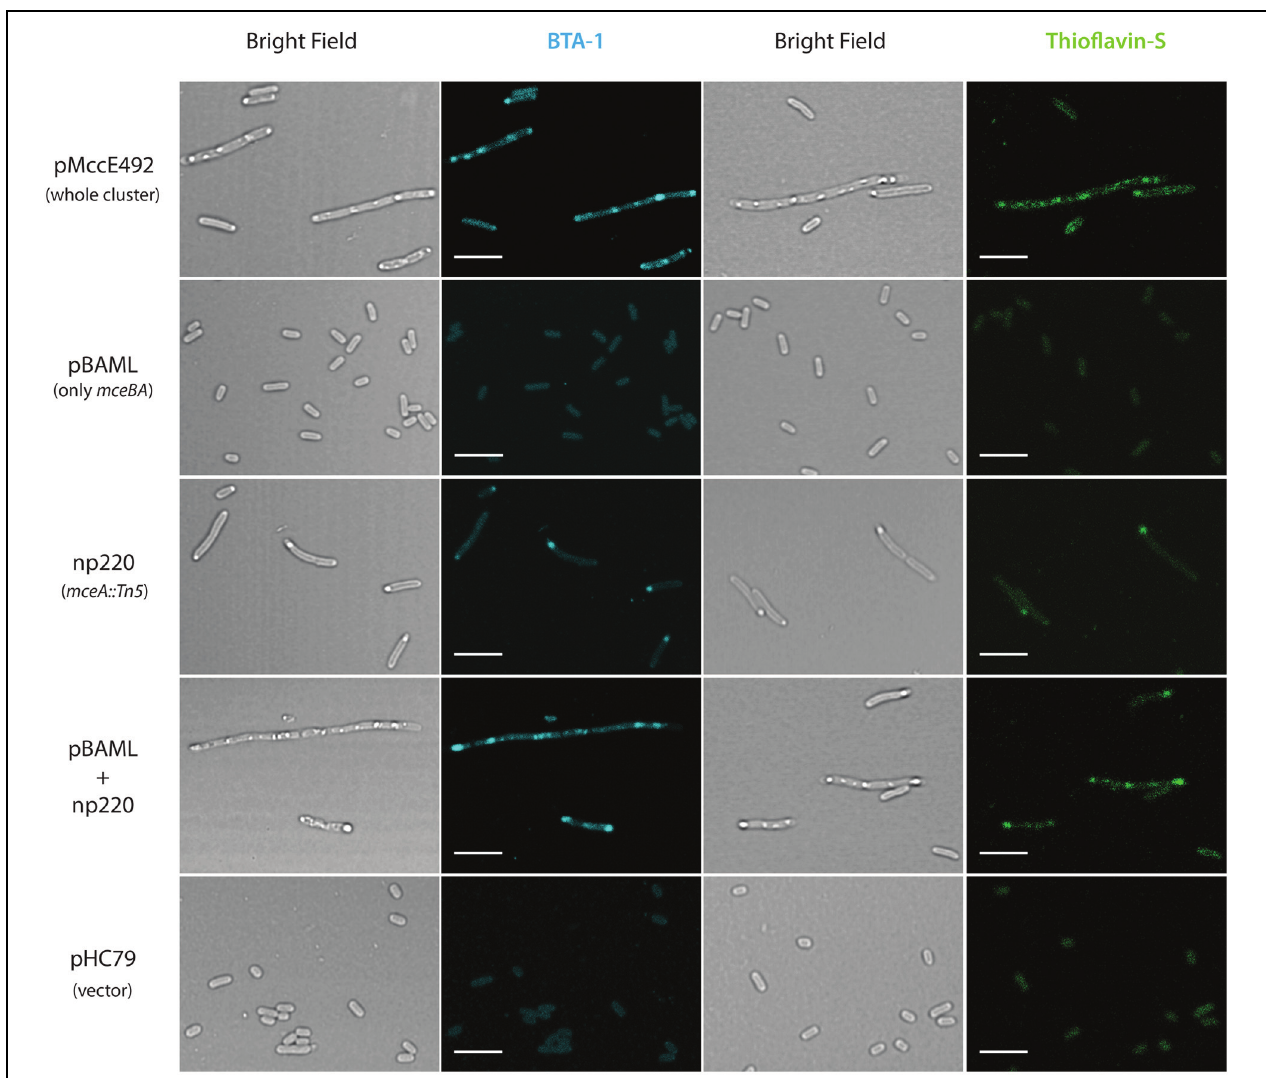
FIGURE 2 | Microcin E492 accumulates as cytoplasmic amyloid inclusions in Escherichia coli cells expressing the whole MccE492 genetic cluster. E. coli cells expressing totally or part of the components of the MccE492 cluster, were grown until stationary phase, stained with the amyloidophilic probes ThS or BTA-1, and visualized by confocal microscopy. Scale bar: 5 μ m. pHC79 is the vector used in the constructions pMccE492 and